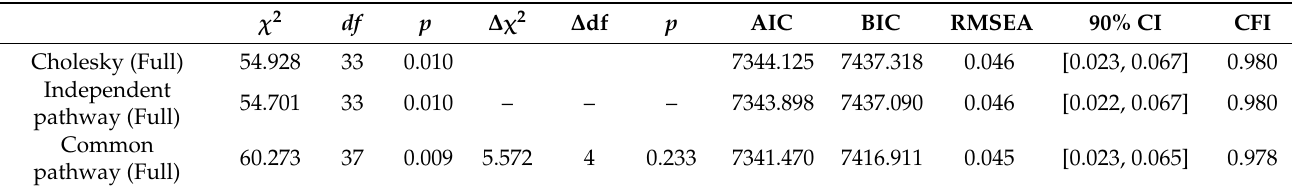
Table 3. Results of model